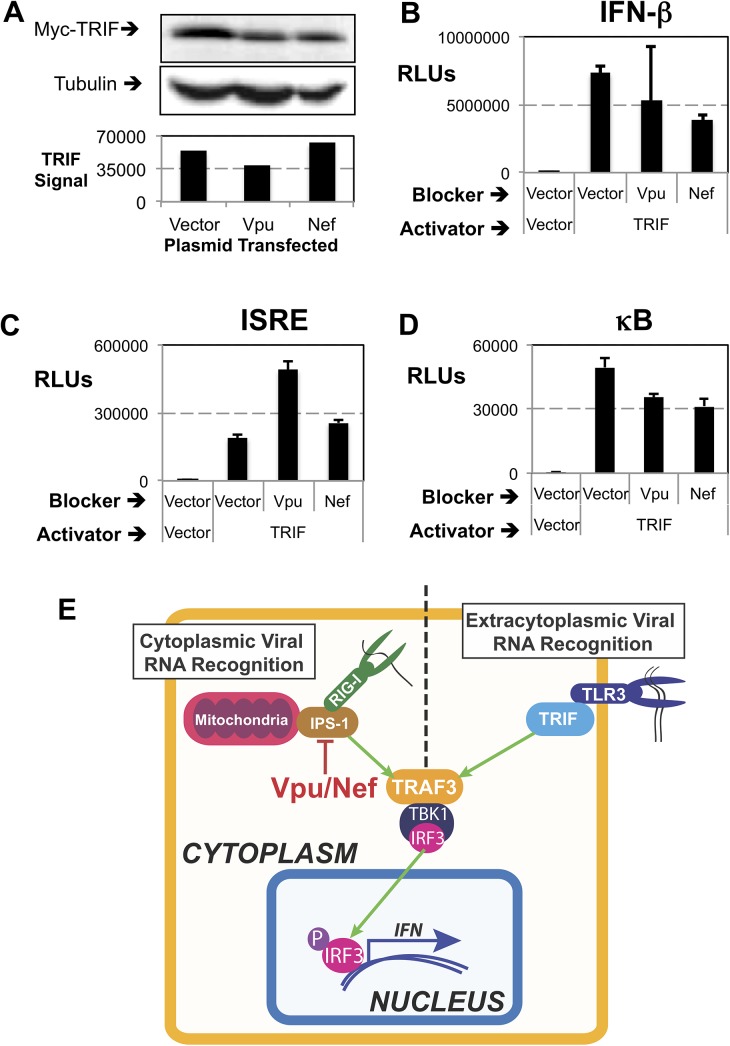
Vpu and Nef Do Not Block Other IFN-Inducing Signaling.(A) Cells were transfected with TRIF expression plasmids containing a Myc tag fused to TRIF and the indicated plasmids. Whole cell lysates were analysed by Western blot for the levels of Myc and endogenous tubulin. HRP catalysed light release was digitally recorded and displayed as a picture as well as quantified as a measure of the target band intensity divided by the intensity of the tubulin cell loading control. (B-D) TRIF overexpression was used to induce the IFN-β (B), ISRE (C) or κB (D) reporters. For B and C, Vpu and Nef induced changes have p values >0.0001. For D, the decreased in kB signalling induced by B and C have a p value > 0.001. In addition, cells were cotransfected with expression plasmids for either Vpu or Nef and the levels of luciferase were analysed. Reporter activation was measured, and graphed in relative light units normalized to cotransfected Renilla luciferase (designated RLUs). (E) A Diagram of cellular IFN induction pathways. The left hand side contains the Cytoplasmic Viral RNA Recognition pathway including RIG-I and IPS-1. The right hand side has an extracytoplasmic viral RNA recognition pathway exemplified by TLR3/TRIF signalling. The convergence of the two pathways is focused at TRAF3 with downstream signalling leading to TBK1 mediated activation of IRF-3.